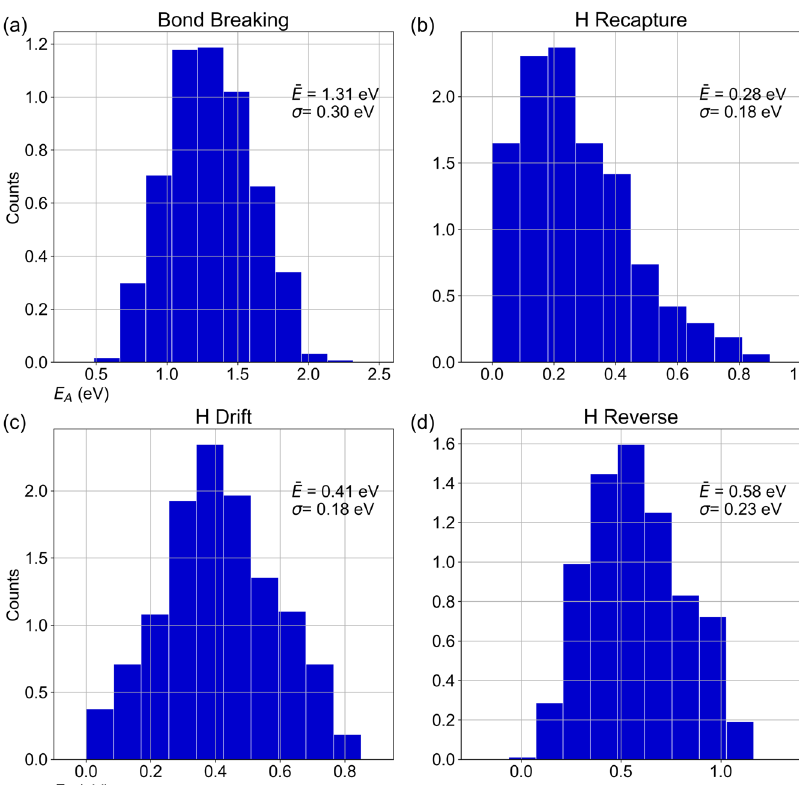
Fig. 3 Energy barrier distributions that control hydrogen dynamics. The distribution, mean value and standard deviation of the energy barriers are shown for the four key processes that control the activated thermal motion of hydrogen at the c-Si/a-Si:H interface. a Freeing a hydrogen atom by breaking a Si – H bond at interface. b Recapture of the freed H atom back to the Si – H bond. c Activated drift of H atom away from the interface. d Reverse drift toward